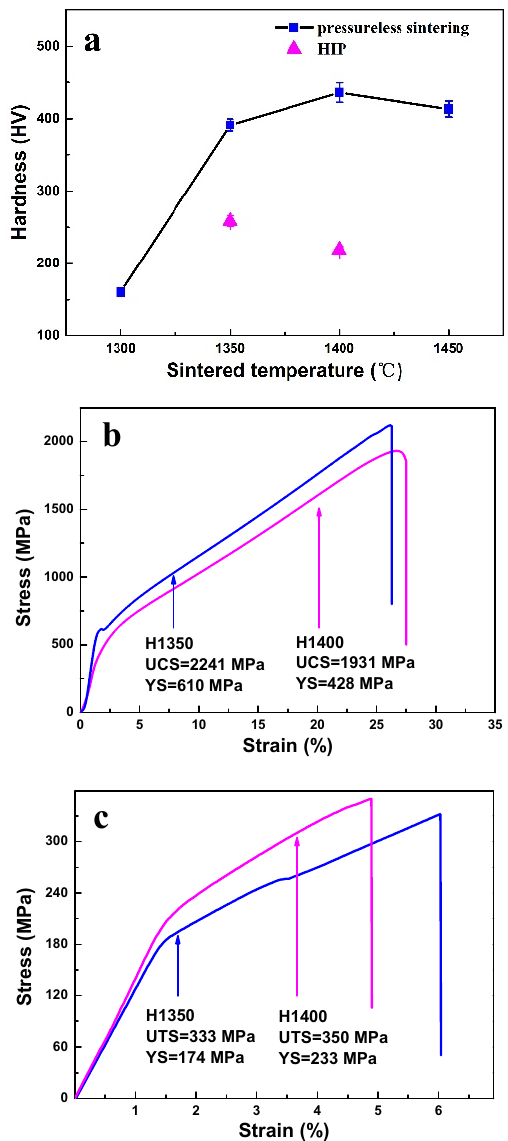
Figure 8. ( a ) Hardness, ( b ) compression properties, and ( c ) tensile properties of the prepared PM Ti-Al alloys. UCS: ultimate compressive strength, YS: yield strength, UTS: ultimate tensile strength.